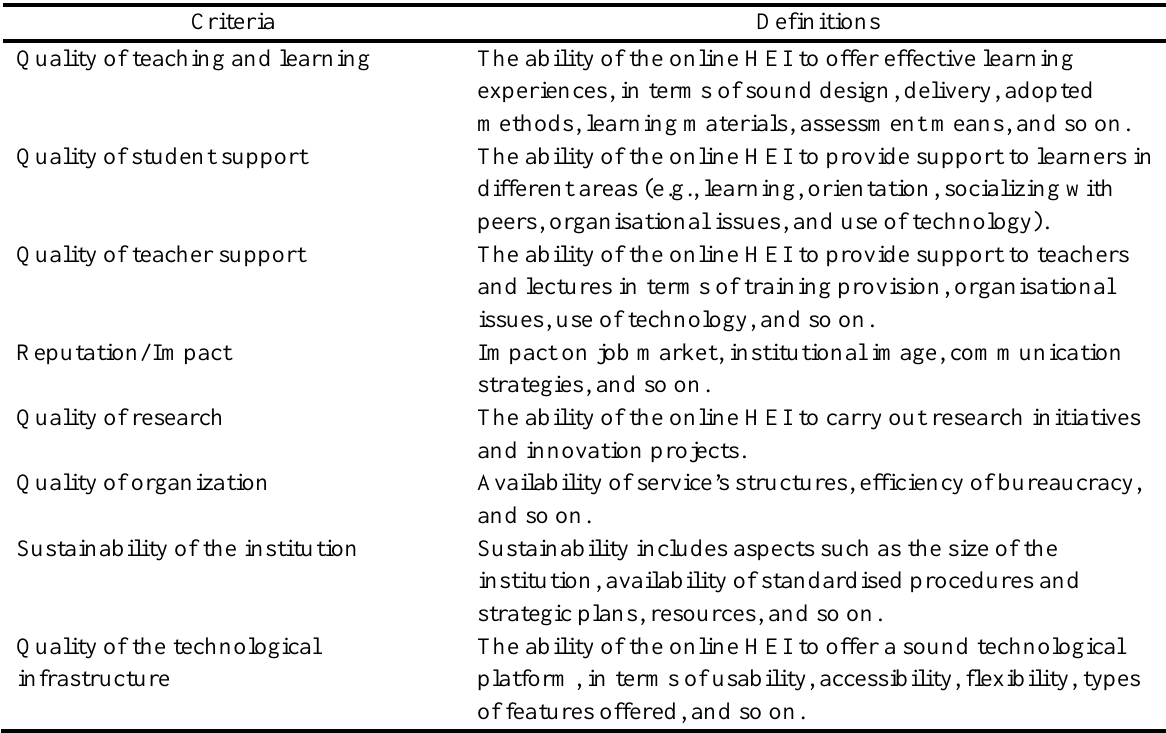
List of Agreed Criteria and Their Definitions (Outcome of Round